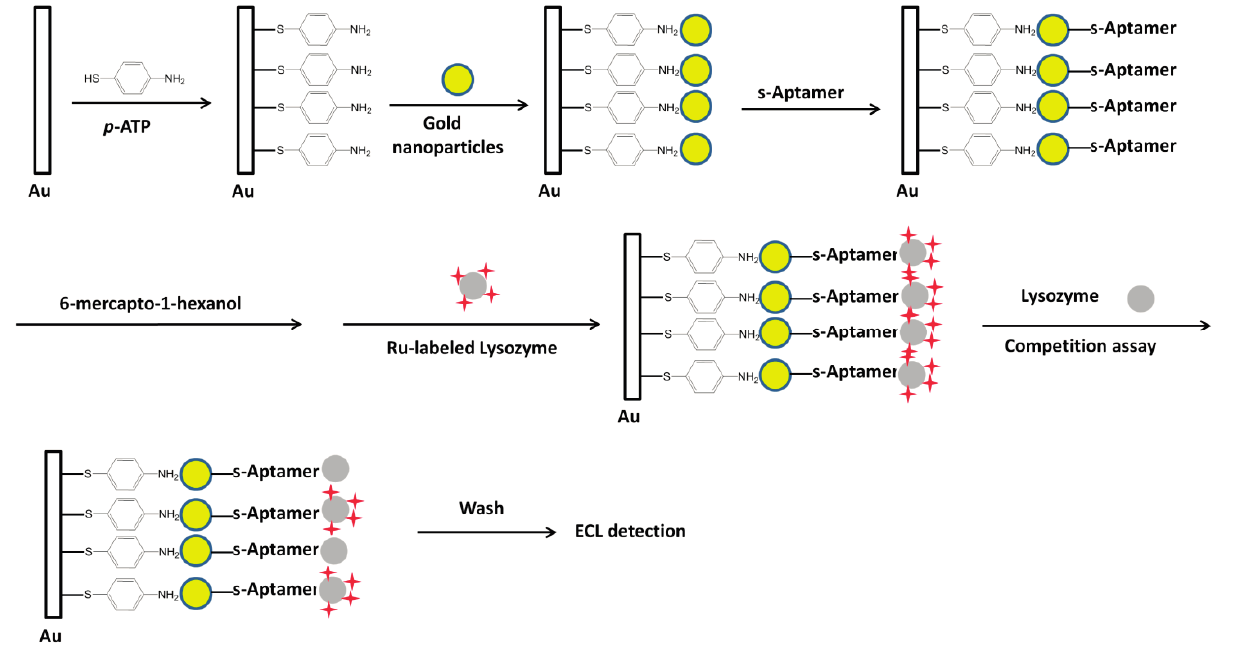
Figure 18. ECL aptasensor for lysozyme detection using Ru(bpy) 32+ as ECL luminophore. p -ATP, p -aminothiophenol. Reprinted with permission from ref. [84], copyright (2008) John Wiley and